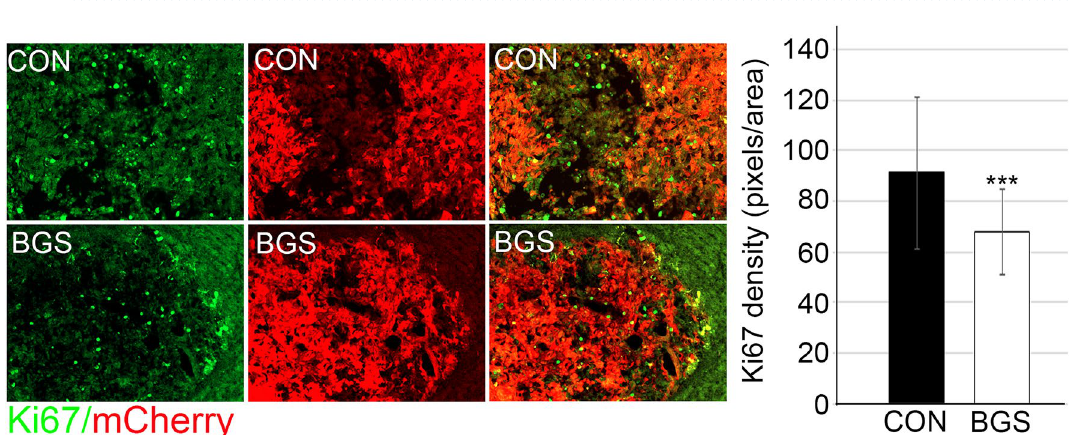
Figure 3. BGS treatment inhibited RET cell proliferation. Representative images of the control and BGS treatments for Ki67 proliferating marker expression (green) in the tumor (mCherry). Ki67 density is significantly reduced in the BGS-treated group compared to the control group. Results are presented as mean ± SD (n = 7 animals/group; ***p < 0.001). Scale bar 200